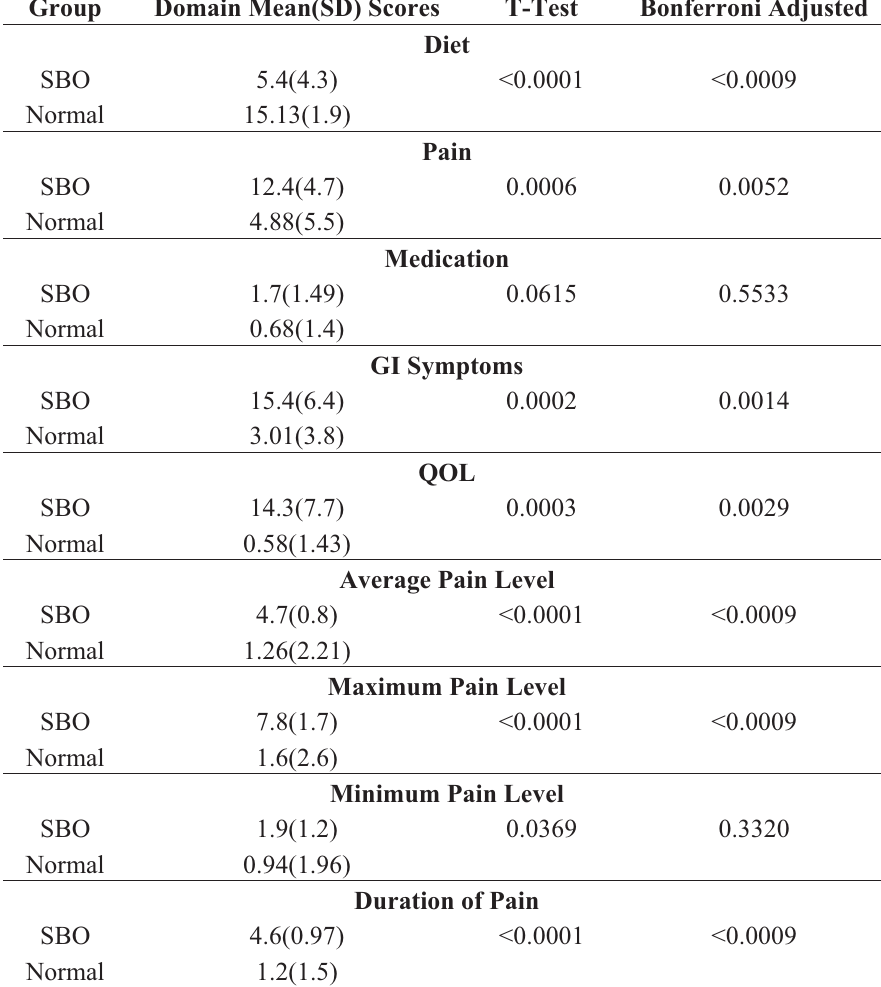
Table 4. Comparison of the normal population and SBO groups for condition specific validity for all domains measured in the SBO QOL